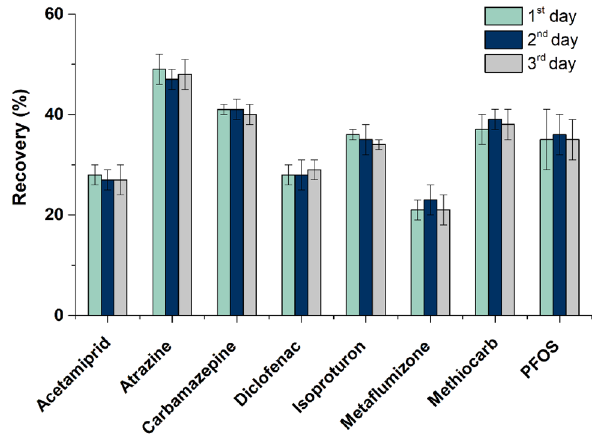
Figure 5. Recoveries obtained for micropollutants (200 ng L −1 each), extracting 1000 mL of water (pH 7) with 8 mL of ethanol as solvent, during consecutive reuse cycles performed with the same multi-layer carbon-based cartridge (bottom: 25 mg of CX; top: 25 mg of MWCNT); n = 3 (RSD is represented as error